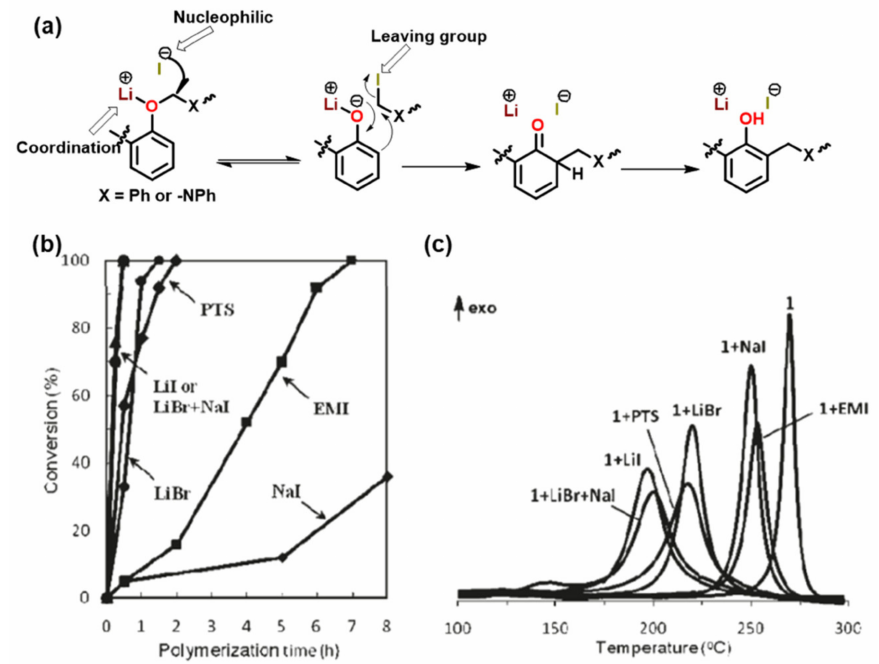
Figure 52. ( a ) Proposed LiI promoted rearrangement reaction, ( b ) time dependences of conversion of pC-a for the polymerization with 1 mol% various catalysts at 150 ◦ C, ( c ) DSC plots of pC-a and its mixtures with 1 mol% of various catalysts [307]. Copyright 2011. Reproduced with permission from American Chemical Society.